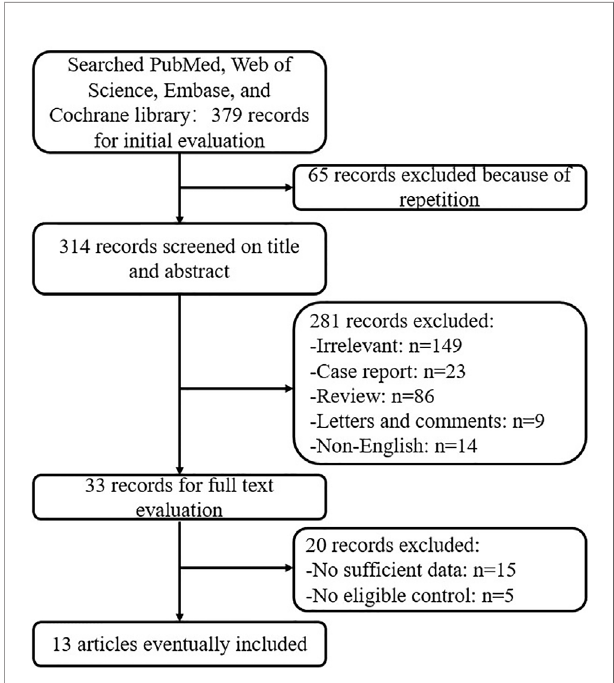
FIGURE 1 | Flowchart of the selection process in the